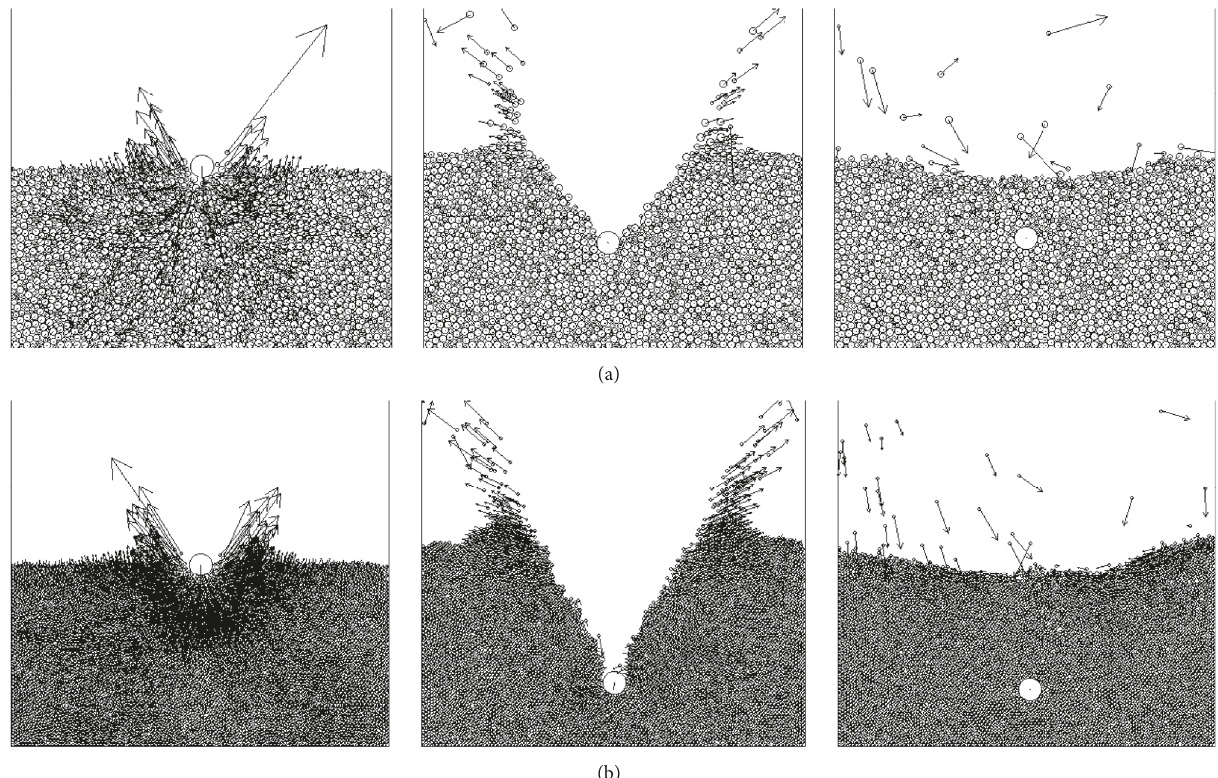
Figure 1: Simulation sequential snapshots of normal penetration process at, respectively, 𝑡 = 0.2sec, 4.6 sec, and 16.4sec. (a) Multisized particle bed. (b) Monosized particle